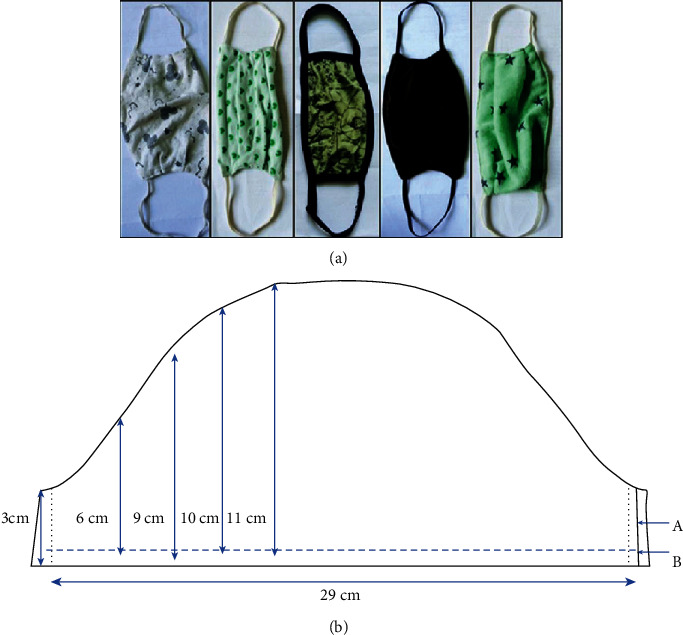
(a) Photos showing examples of simple cloth masks. Reproduced with permission from Ref. [91]. Copyright 2019, Neupane et al., PeerJ. (b) Schematic showing the pattern for a homemade mask. Reproduced with permission from Ref. [92]. Copyright 2020, Springer Nature.